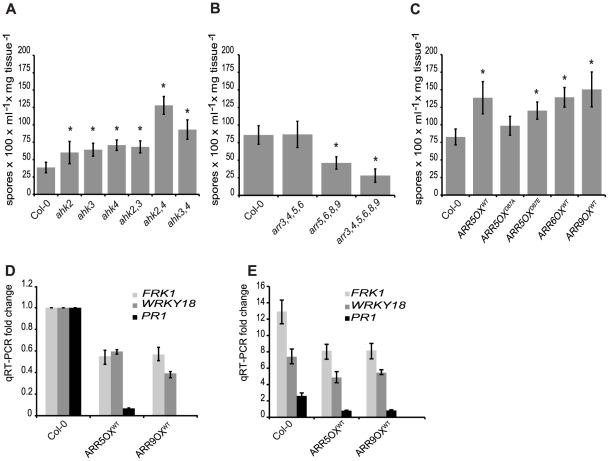
A two-component phosphorelay, negatively regulated by type-A ARRs, is required for defense responses.(A) Susceptibility of ahk receptor single and double mutants to Hpa Noco2. Two-week-old plants were inoculated with Hpa Noco2 and spore production measured as described in Methods. Error bars represent SE (n≥4). Asterisks indicate statistically significant differences from wild-type plants (p-value<0.05, two-tailed student's t-test). The experiment was repeated at least three times independently. Data from one representative experiment are shown. (B) Susceptibility of type-A arr multiple mutants to Hpa Noco2. Two-week-old plants were inoculated with Hpa Noco2 and spore production measured as described in Methods. Error bars represent SE (n≥4). Asterisks indicate statistically significant differences from wild-type plants (p-value<0.05, two-tailed student's t-test). The experiment was repeated at least three times independently. Data from one representative experiment are shown. (C) Susceptibility of transgenic lines overexpressing type-A ARRs to Hpa Noco2. Two-week-old wild-type plants or transgenic lines overexpressing wild-type (ARR5, ARR6, ARR9), phospho-mimic (ARR5D87E) and phospho-deficient (ARR5D87A) forms of type-A ARRs were inoculated with Hpa Noco2 and spore production measured as described in Methods. Error bars represent SE (n≥4). Asterisks indicate statistically significant differences from wild-type plants (p-value<0.05, two-tailed student's t-test). The experiment was repeated at least three times independently. Data from one representative experiment are shown. (D) Basal defense gene expression in transgenic lines overexpressing type-A ARRs. Two-week-old wild-type plants or transgenic lines overexpressing wild-type type-A ARRs (ARR5 and ARR9) were inoculated with water. RNA was extracted from tissue harvested three days later. Levels of the indicated transcripts were determined by qRT-PCR relative to wild-type plants. Error bars represent SE from three technical replicates and correspond to upper and lower limits of 95% confidence intervals. At least three independent biological replicates of the experiment were conducted with similar results. Data from one representative independent biological replicate are shown. (E) Defense gene expression in response to Hpa Noco2 in transgenic lines overexpressing type-A ARRs. Two-week-old wild-type plants or transgenic lines overexpressing wild-type type-A ARRs (ARR5 and ARR9) were inoculated with water or Hpa Noco2. RNA was extracted from tissue harvested at 3 dpi. Levels of the indicated transcripts were determined by qRT-PCR relative to water-treated samples. Error bars represent SE from three technical replicates and correspond to upper and lower limits of 95% confidence intervals. At least three independent biological replicates of the experiment were conducted with similar results. Data from one representative independent biological replicate are shown.